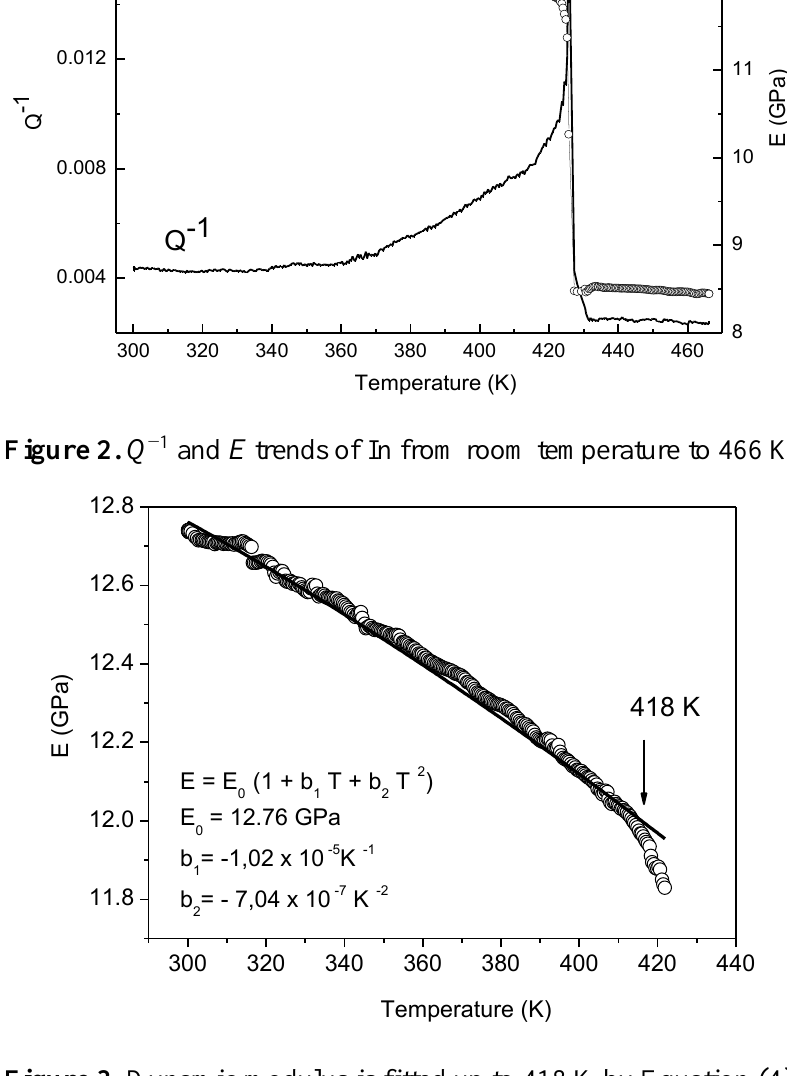
Figure 3. Dynamic modulus is fitted up to 418 K by Equation